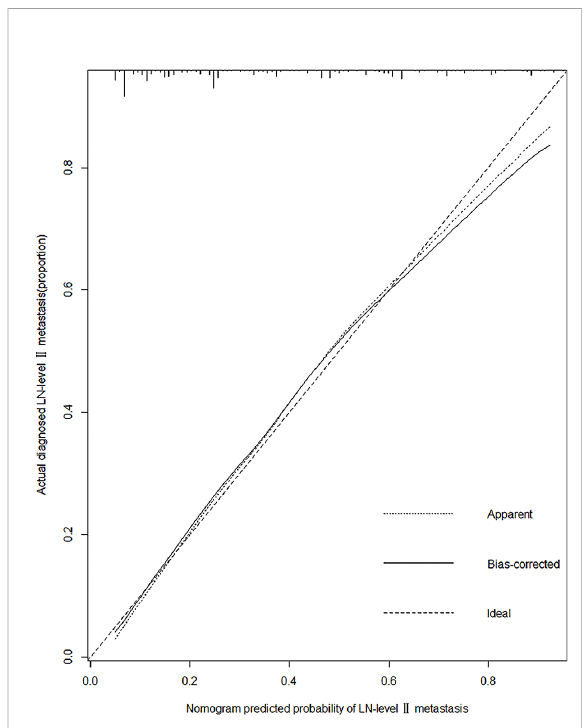
FIGURE 2 Calibration plot of the model. The calibration curve depicts the calibration of the model in terms of the agreement between the predicted risks of LN-level II metastasis and observed outcomes of LN-level II metastasis. The x-axis represents the predicted LN- level II metastasis risk. The y-axis represents the actual LN-level II metastasis rate. The diagonal dotted black line represents an ideal calibration model in which the predicted probabilities are identical to the actual outcomes. The dotted line represents the predictive performance of the nomogram; the closer the fi t of the dotted line to the ideal line, the better the prediction. The black line represents the